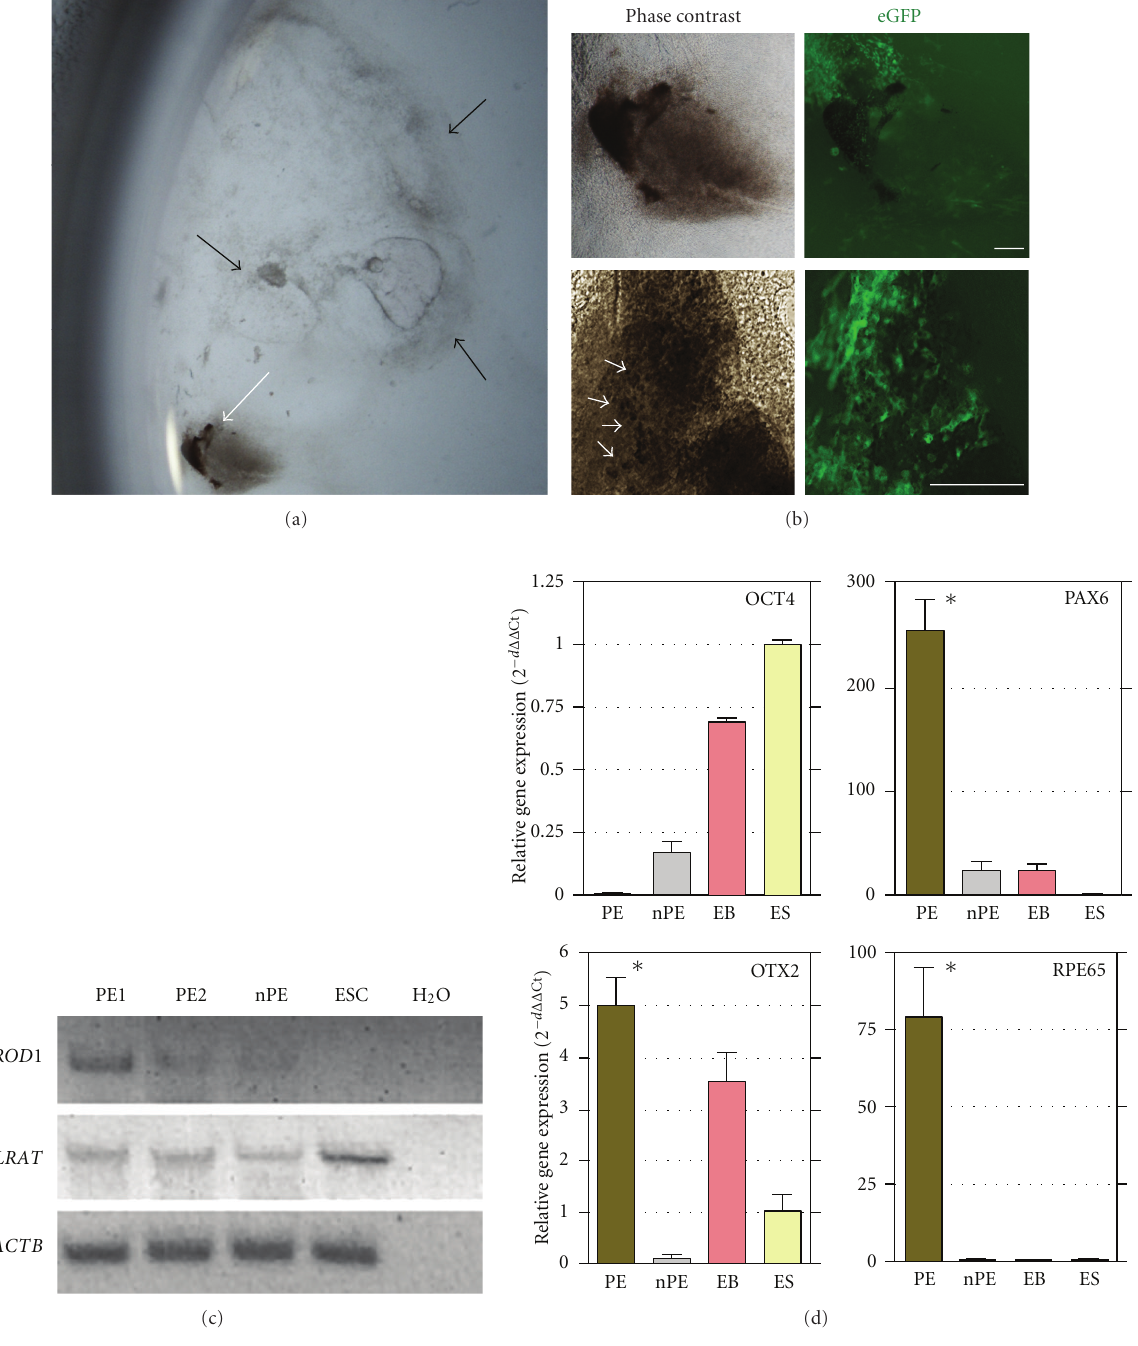
Figure 5: Di ff erentiation of retinal pigmented epithelium (RPE) from Callithrix ESCs. (a) Stereoscopic image of cell outgrowth following EB replating. The white arrows indicate the visible pigmented area derived from an area of EB outgrowth. Black arrows indicate the colonies that did not develop to RPE structures. (b) Phase contrast and green fluorescence of the pigmented epithelium in RPE patch-like structures. The white arrowheads indicate the presence of putative RPE cells with typical pigmented cobblestone-like morphology. Scale bars, 200 μ m. (c) Semiquantitative PCR analysis of manually picked clusters of pigmented epithelium (PE1 and PE2), nonpigmented cells (nPE), and undi ff erentiated ESCs. Water (H 2 O) only was included as negative control. (d) Relative expression levels of OCT4, PAX6, OTX2s and RPE65 mRNA in PE, nPE, embryoid bodies (EB), and undi ff erentiated ES cells (ES). Mean normalized expression of each target gene is relative to ACTB and GAPDH housekeeping genes. Error bars represent standard deviation. Asterisk shows significant di ff erence of PAX6, OTX2, and RPE65 expression in PE clusters, P < 0 .